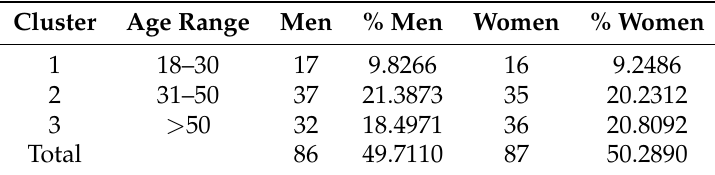
Table 2. Number of surveys assigned to each